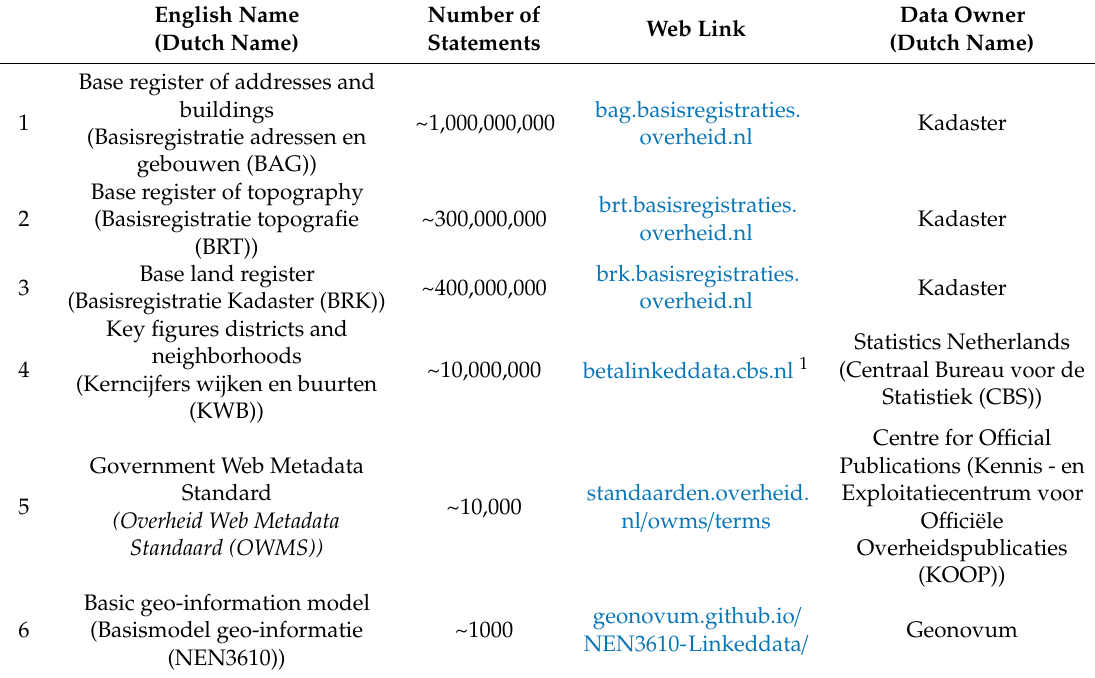
Table 1. Kadaster Knowledge Graph (KKG) data sources that were o ffi cially published as linked data (LD). (Source: authors).